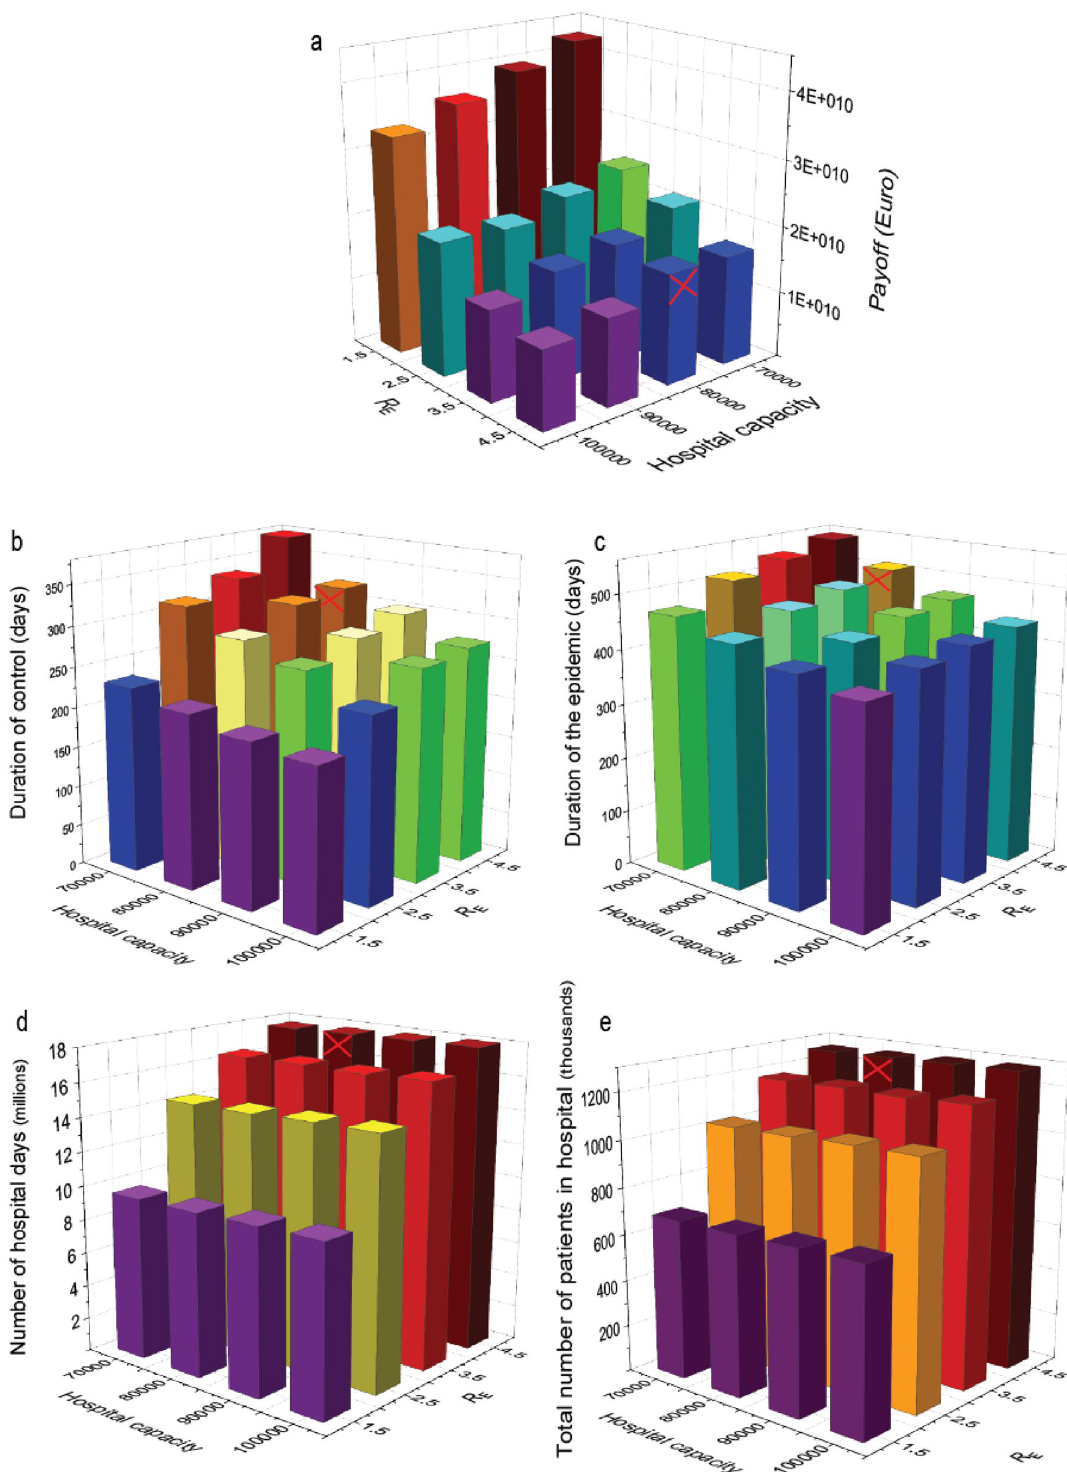
Figure 6. Characteristics of the economic effects of epidemic and the payoff as function of the strategies. ( a ) The payoff of the state (Supplementary Table 9). Colors are visual aids to assess height of the bars. The optimal solution is at 800,000 beds for the worst case of a pathogen having R E = 4.5 . The bar corresponding to this case is marked with red crossed lines. In the calculations, the payoff depended on the following “background variables”: ( b ) Duration of the control (Supplementary Table 5); ( c ) duration of the whole epidemic (Supplementary Table 6); ( d ) total number of hospital days during the epidemic (Supplementary Table 7); ( e ) total number of patients in hospital during the epidemic (Supplementary Table 8). Clearly, these background variables depend on the characteristic of the pathogen and the available hospital capacity, and thus affect the economic effect of the